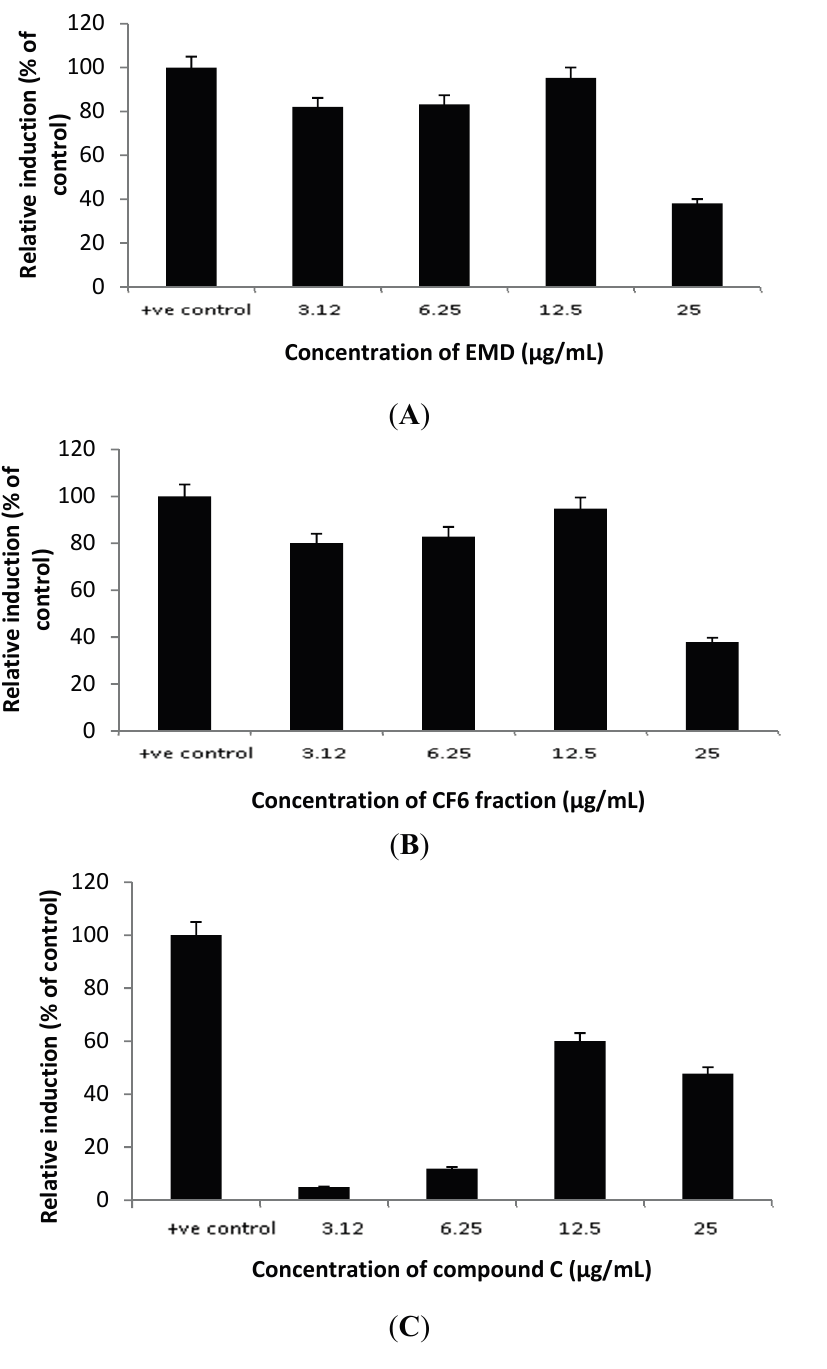
Figure 2. The effects of EMD ( A ), CF6 ( B ) and 2',6',4 trihydroxy-4' methoxybenzophenone ( C ) from P. macrocarpa leaves on the transcriptional activity of SR-BI